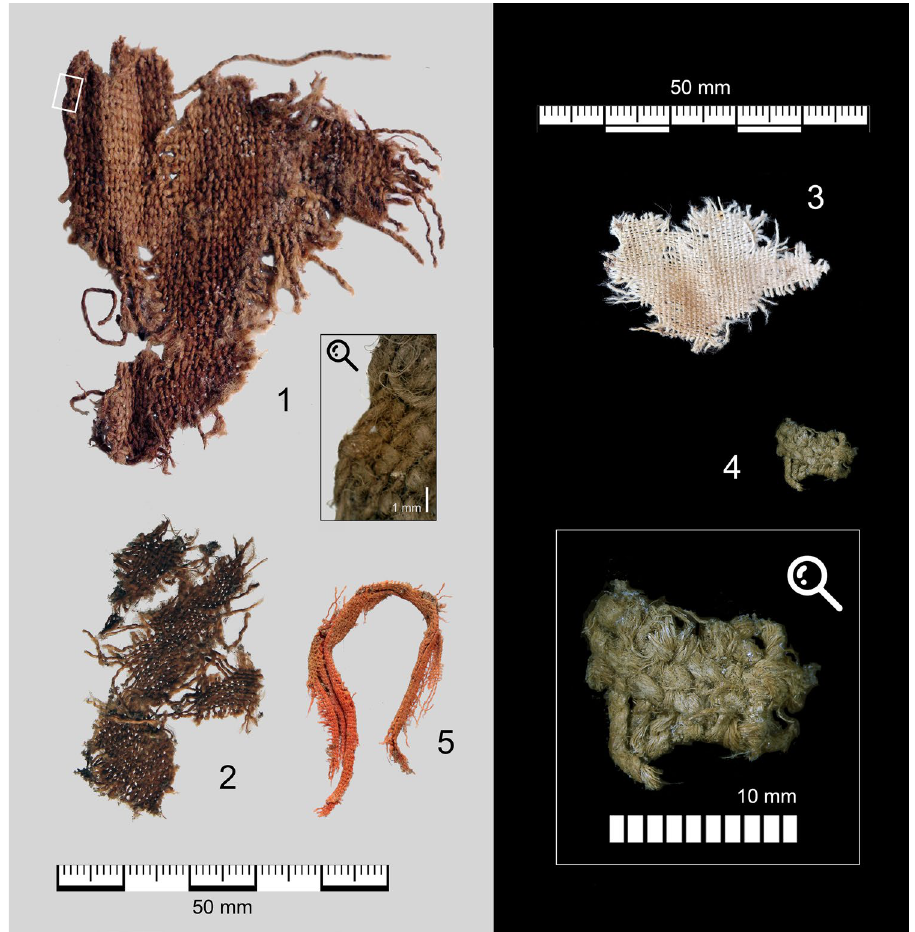
Figure 2. Textiles 1–5 recovered from Pañacalera at the same scale. For technical details of all fragments, see Table